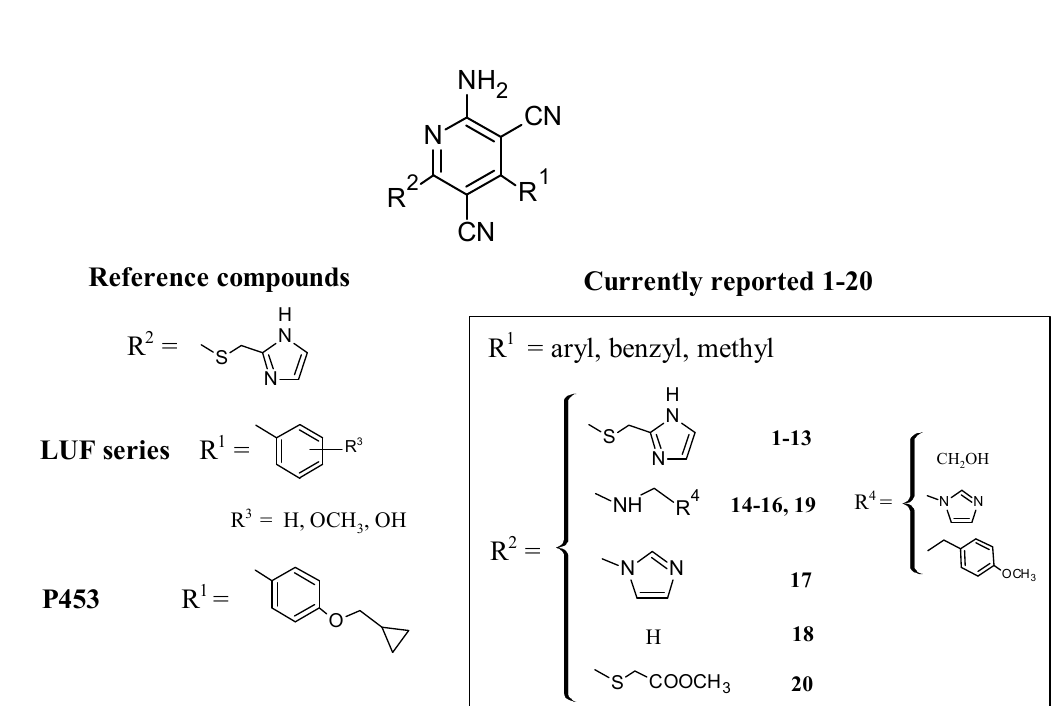
Figure 1. Lead structures and currently reported amino-3,5-dicyanopyridine-based adenosine receptor ligands.